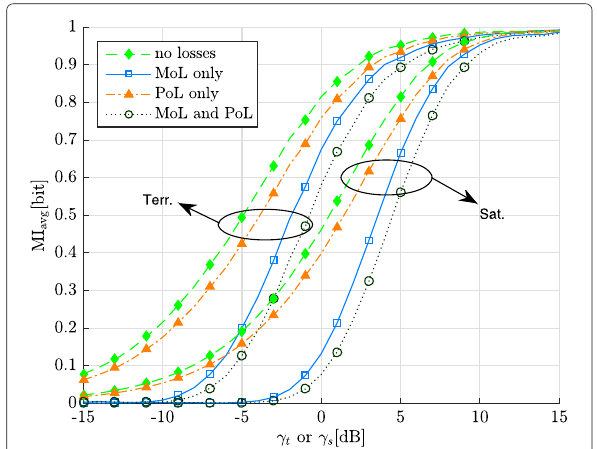
Fig. 2 MoL and PoL for the terrestrial and satellite channel (2-PAM, N U = N T = 7, θ =